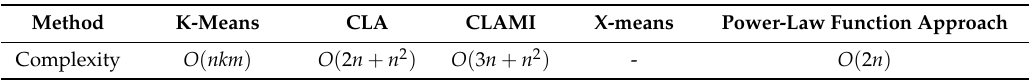
Table 7. Complexity of the tested